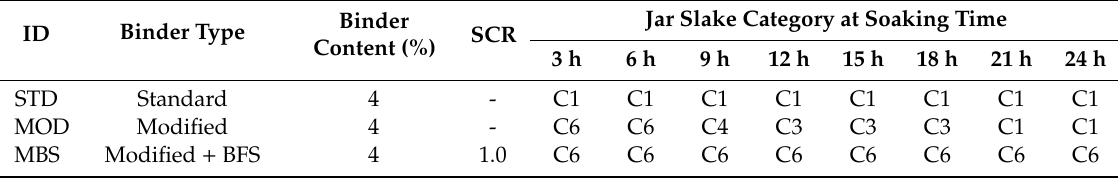
Table 8. Result of the jar slake test.